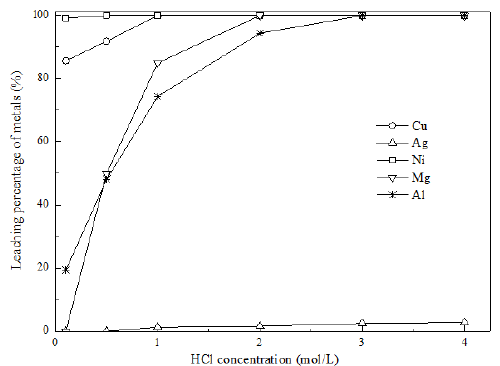
Figure 3. The effect of HCl concentration on the leaching of metals from the industrial dust.